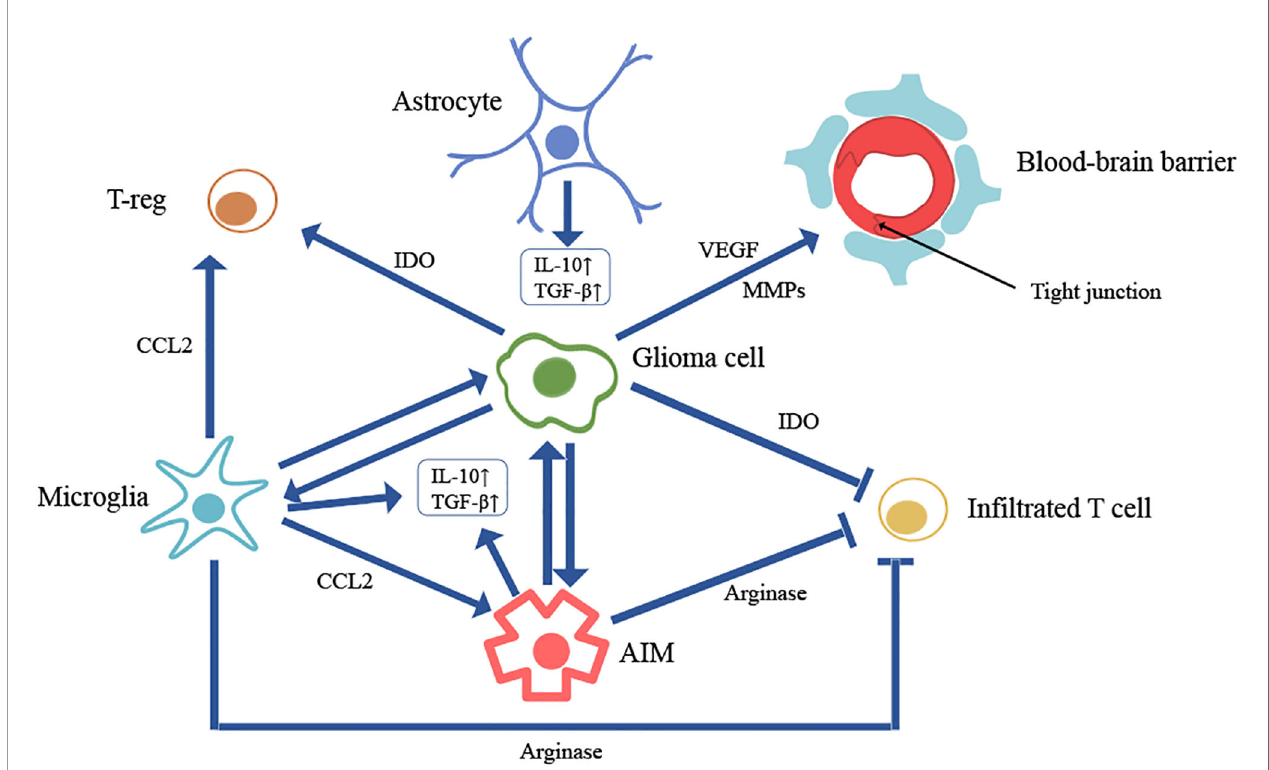
FIGURE 1 | Cell interactions in brain tumor microenvironment. Microglia can 1) modulate glioma growth via facilitating proliferation, invasion and stemness of glioma; 2) promote the recruitment of T-reg cells and anti-in fl ammatory macrophages (AIM) from systemic circulation through the release of chemokine ligand 2 (CCL2); 3) produce high level of immunosuppressive cytokines like transforming growth factor b (TGF b ) and interleukin-10 (IL-10); 4) produce a large amount of arginase to inhibit T cell proliferation and function by depleting tissue arginine levels. AIM can 1) support tumorigenesis; 2) produce high level of immunosuppressive cytokines like TGF b and IL-10; 3) produce a large amount of arginase to inhibit T cell proliferation and function by depleting tissue arginine levels. Glioma cell can 1) secrete soluble factors (VEGF, MMPs) to destroy the endothelial tight junctions, causing blood-brain barrier leakage; 2) generate a great amount of indolamine 2,3- dioxygenase (IDO) to both inhibit T cell activity and promote the recruitment of regulatory T cells (Treg) through depletion of tryptophan from the microenvironment; 3) attract both microglia and AIM to enhance tumor growth and promote immunosuppression. Astrocyte can also produce high level of immunosuppressive cytokines like TGF b and